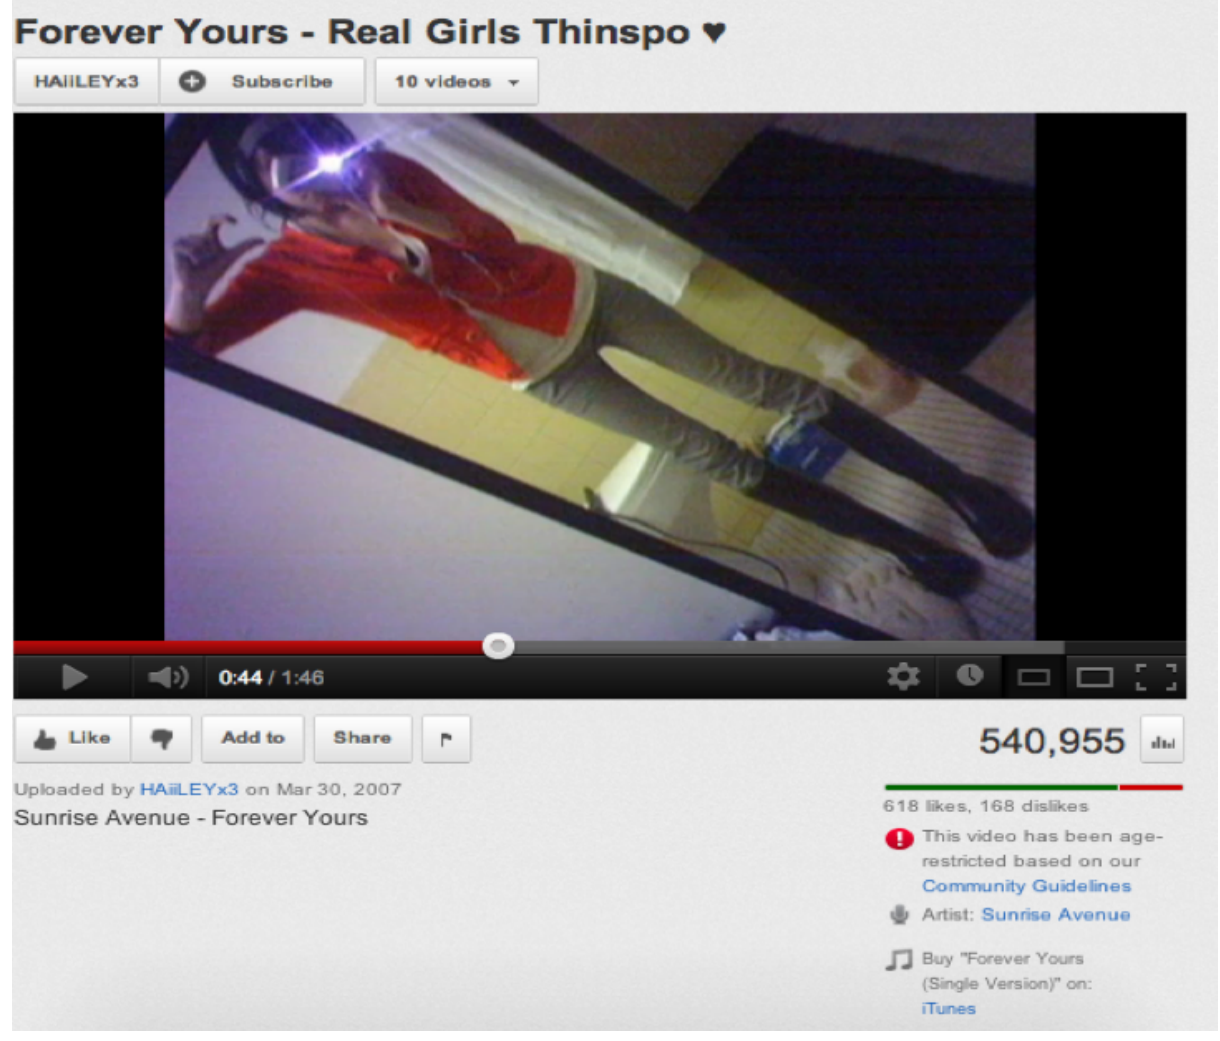
Figure 4. Screenshot of a video promoting anorexia featuring very thin